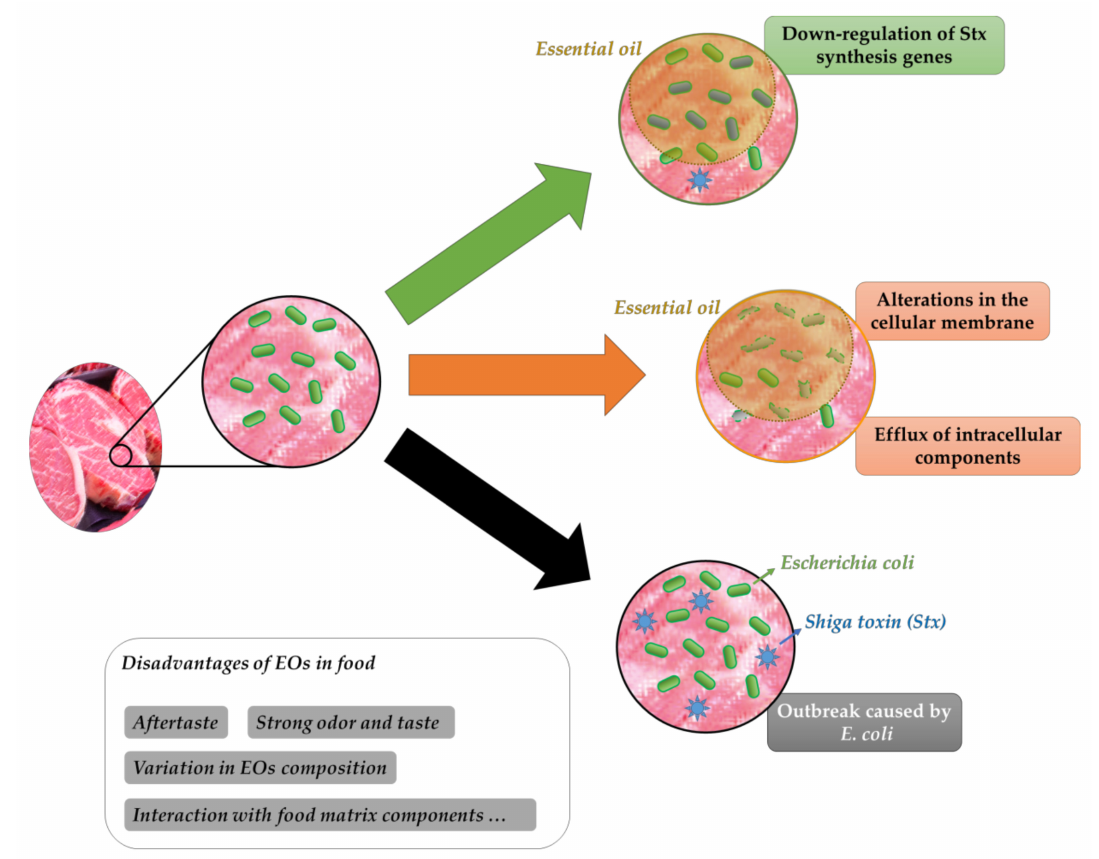
Figure 2. Influence of EOs on pathogenic E. coli and some disadvantages of EOs on